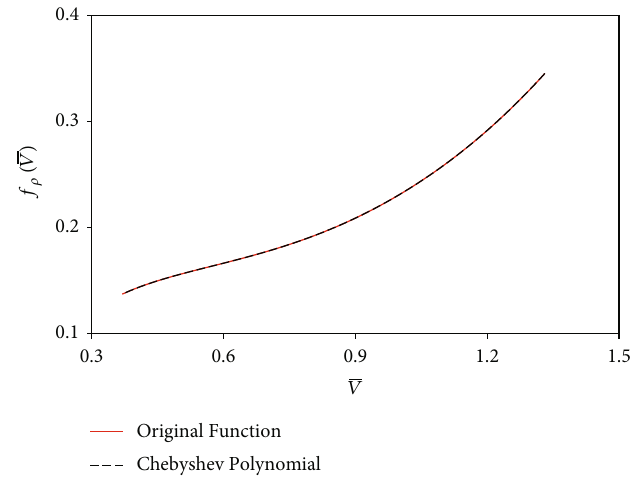
(cid:2) V Þ and the corresponding approximate ρ ð